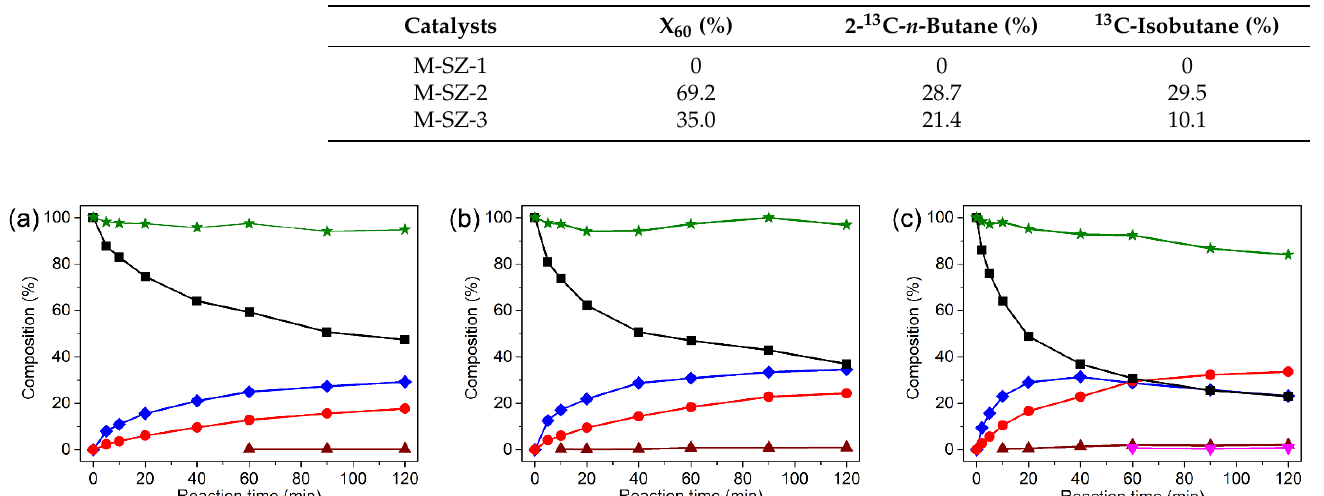
Figure 7. Butane isomerization catalyzed by M-SZ-2 at ( a ) 393 K, ( b ) 413 K, and ( c ) 433 K. ( ■ ) 1- 13 C- n -butane, ( ◆ ) 2- 13 C- n -butane, ( ● ) 1- 13 C-isobutane and 2- 13 C-isobutane, ( ▲ ) 13 C-isopentane, ( ▼ ) 13 C- propane, and ( ★ ) the total amount of 13 C-labeled species.